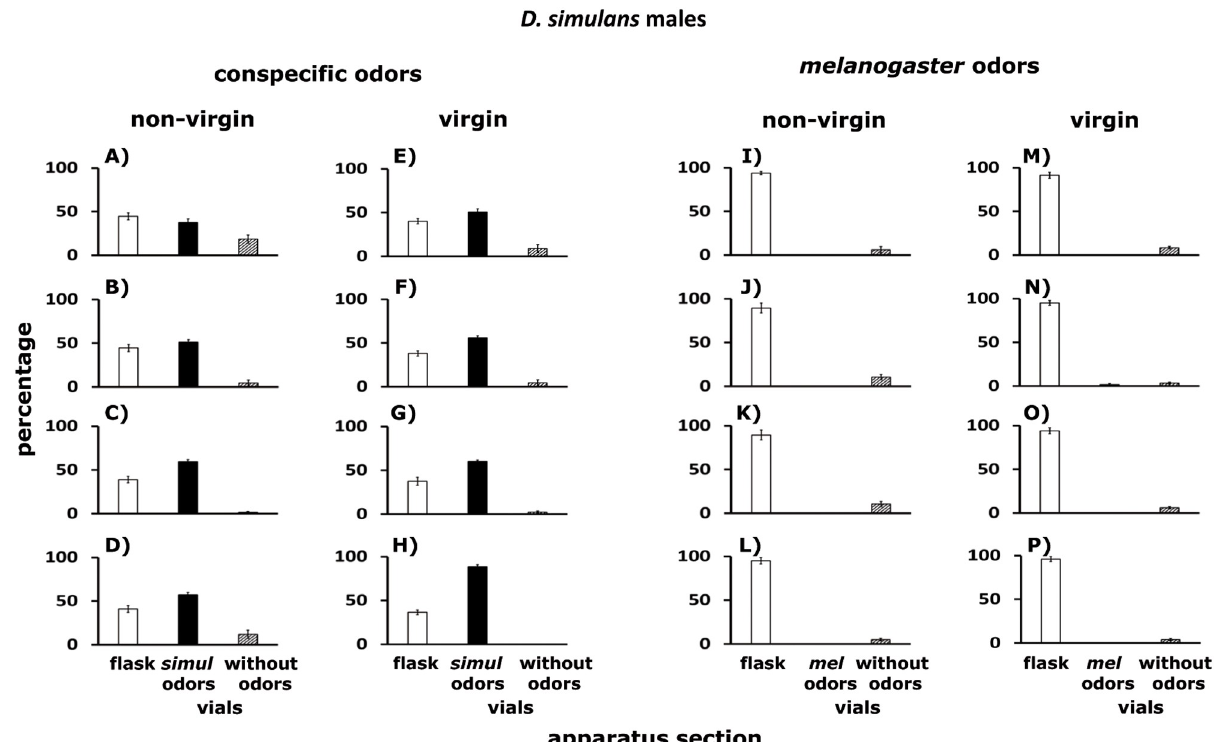
Fig 13. A–P. Dispersal of D . simulans males confronted with odorants of conspecifics and D . melanogaster . Males tested were non-virgin (A–D and I–L) and virgin (E–H and M–P). White columns indicate percentages of flies that remained in the flask. Black columns stand for percentages of flies found in the Y-tubes connected to vials with conspecific (or D . simulans ) odors. Hatched columns show percentages of flies in the Y-tubes connected to empty vials. For further details see Fig